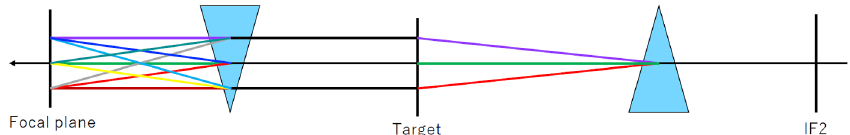
Figure 8. Conceptual illustration of the dispersion match technique. Extracted π beam has a momentum dispersion and it is converted to the spatial dispersion on the experimental target by the HIHR beamline. The kaon spectrometer is designed to cancel this spatial dispersion and the position information on the focal plane gives the excitation energies of the produced hypernuclei.